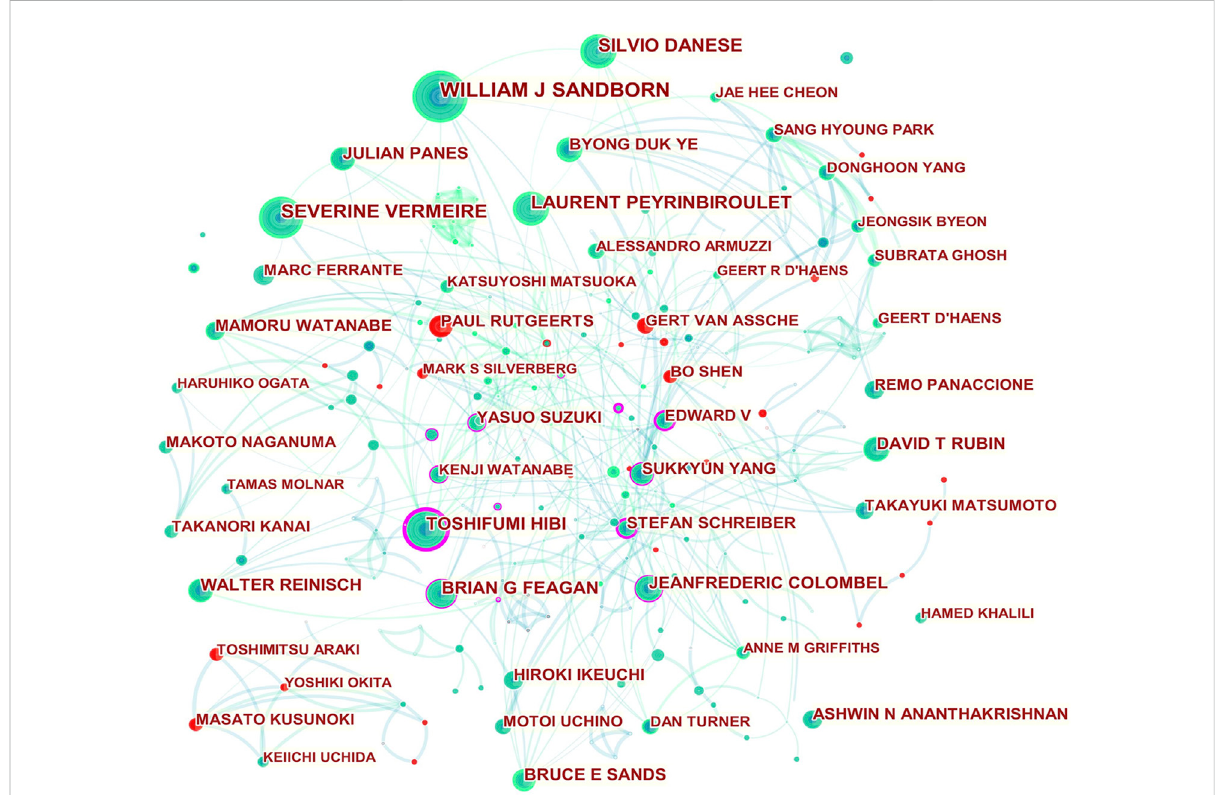
FIGURE 4 Network of authors in UC research. Note: An individual node represents an author on the network map. The greater the area of the node, the more publications there are. The thicker the curved line connecting nodes, the more frequent their co-occurrence, as this indicates a collaborative relationship. An isolated node with no link lacks all collaboration. When a node has a high betweenness centrality ( > 0.1) (i.e., when it is connected to more than 10% of the other nodes), it exerts signi fi cant in fl uence over others as it controls most resources within their collaborative networks (Cobo et al., 2011). The presence of a purple rim also indicates a high degree of betweenness centrality. Red tree rings indicate bursts of citation, indicating high scholarly activity. Red tree rings with a greater thickness show a greater burst for a corresponding